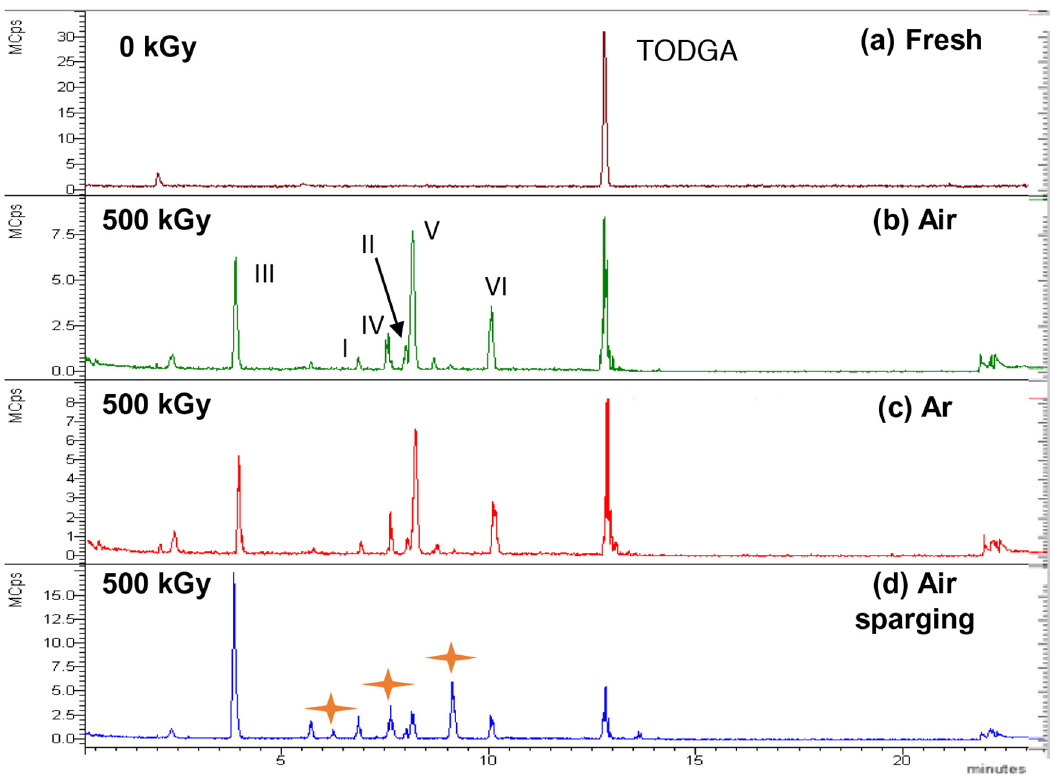
Fig. 3. HPLC-MS chromatograms of TODGA solvents (a) fresh as reference material, (b) in presence of air irradiated up to 500 kGy, (c) in presence of Argon irradiated up to 500 kGy and (d) air fl ow sparging irradiated up to 500 kGy all of them in contact with 0.5mol/L HNO 3 .